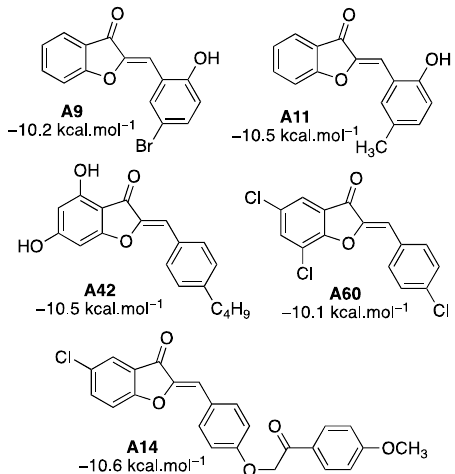
Figure 9. Compounds with the top docking scores and interacting with the key residues of human pancreatic lipase (HPL).